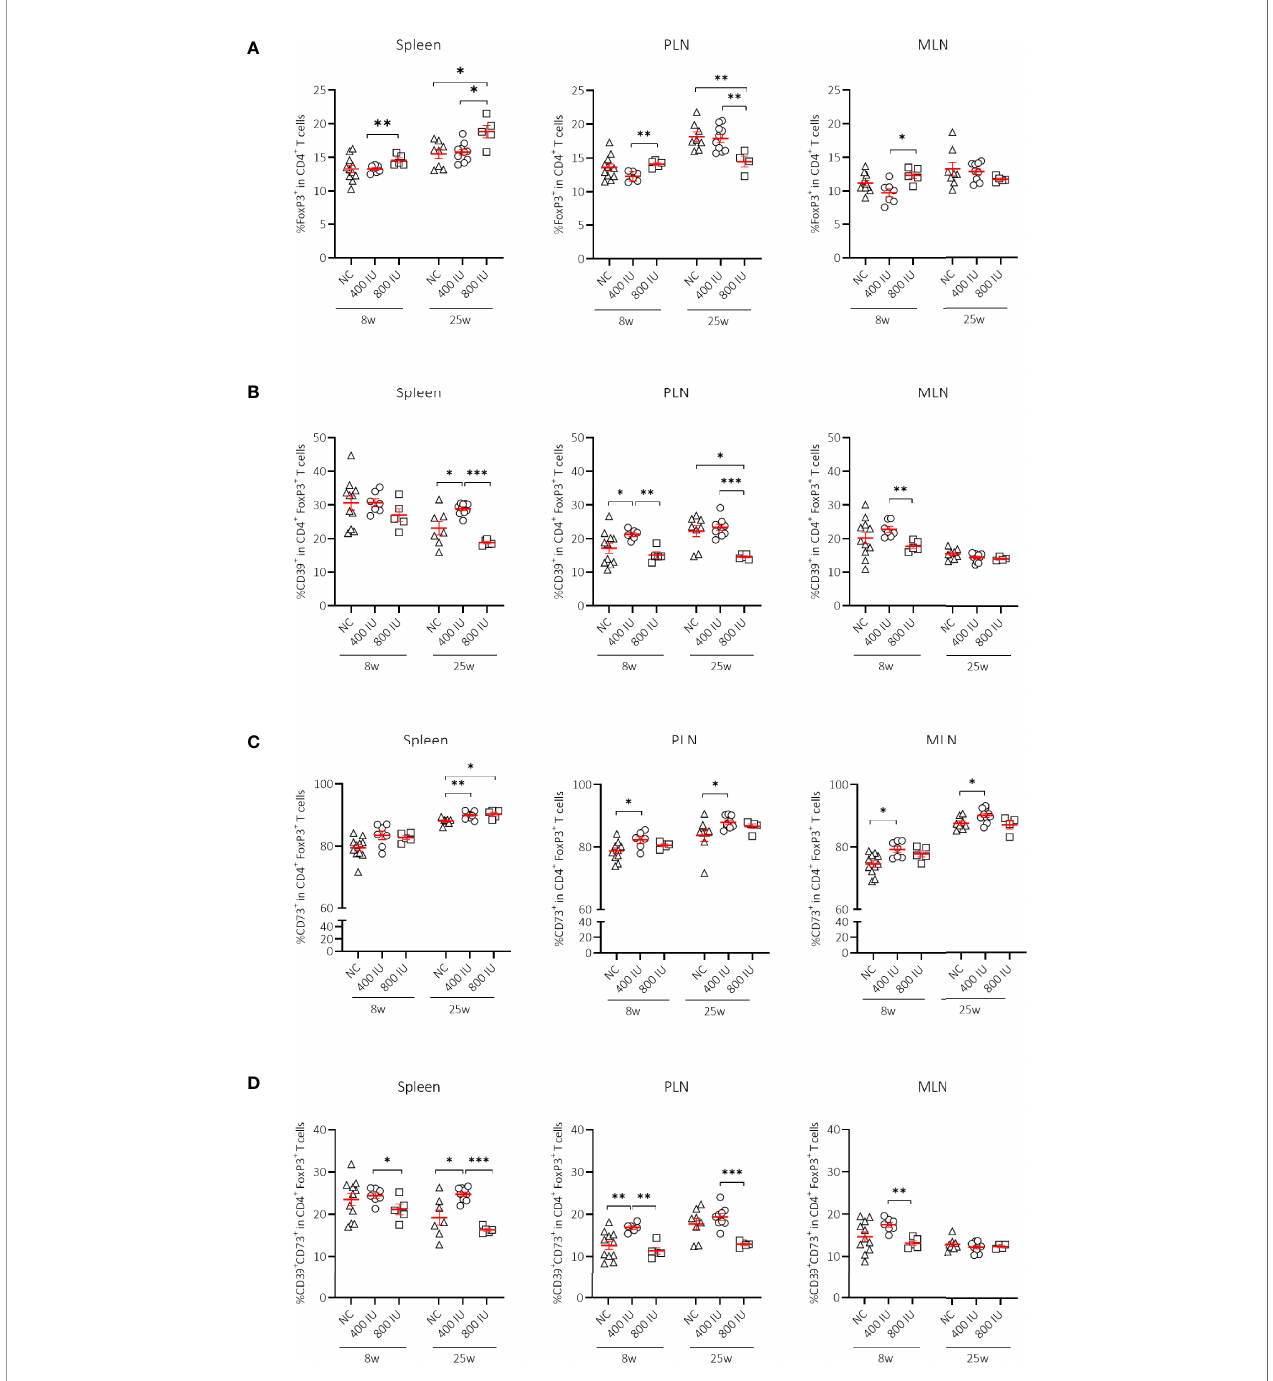
FIGURE 2 | Effect of vitamin D substitution regimen on frequency and functionality of Treg cells. Frequency of FoxP3 + T cells within CD4 + T-cell gate (A) and their functionality as expressed by the frequency of CD39 + (B) , CD73 + (C) or CD39 + CD73 + T cells (D) within FoxP3 + CD4 + T-cell gate are shown at both 8 and 25 weeks of age in spleen, pancreatic draining lymph nodes (PLN), and mesenteric draining lymph nodes (MLN). Female NOD mice were fed normal chow (NC) or two different doses of vitamin D-supplemented (400 or 800 IU/day) diet from 3 until 25 weeks of age (lifelong). Symbols (N = 4-11) represent individual mice, and line re fl ects group mean with SEM. *P ≤ 0.05; **P ≤ 0.01; ***P ≤